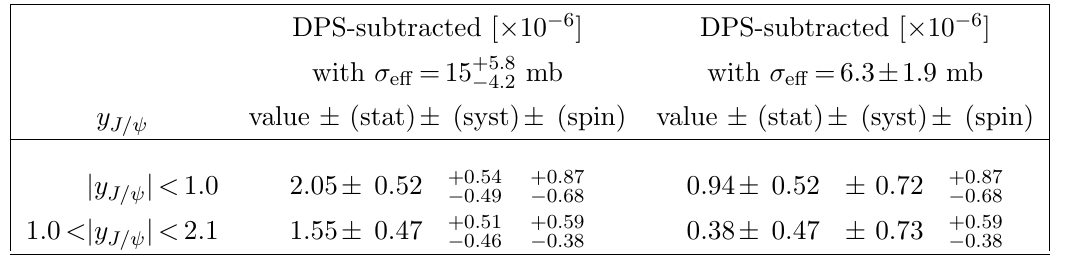
Table 8. The DPS-subtracted di(cid:11)erential cross-section ratio in two regions of y values of (cid:27) e(cid:11)